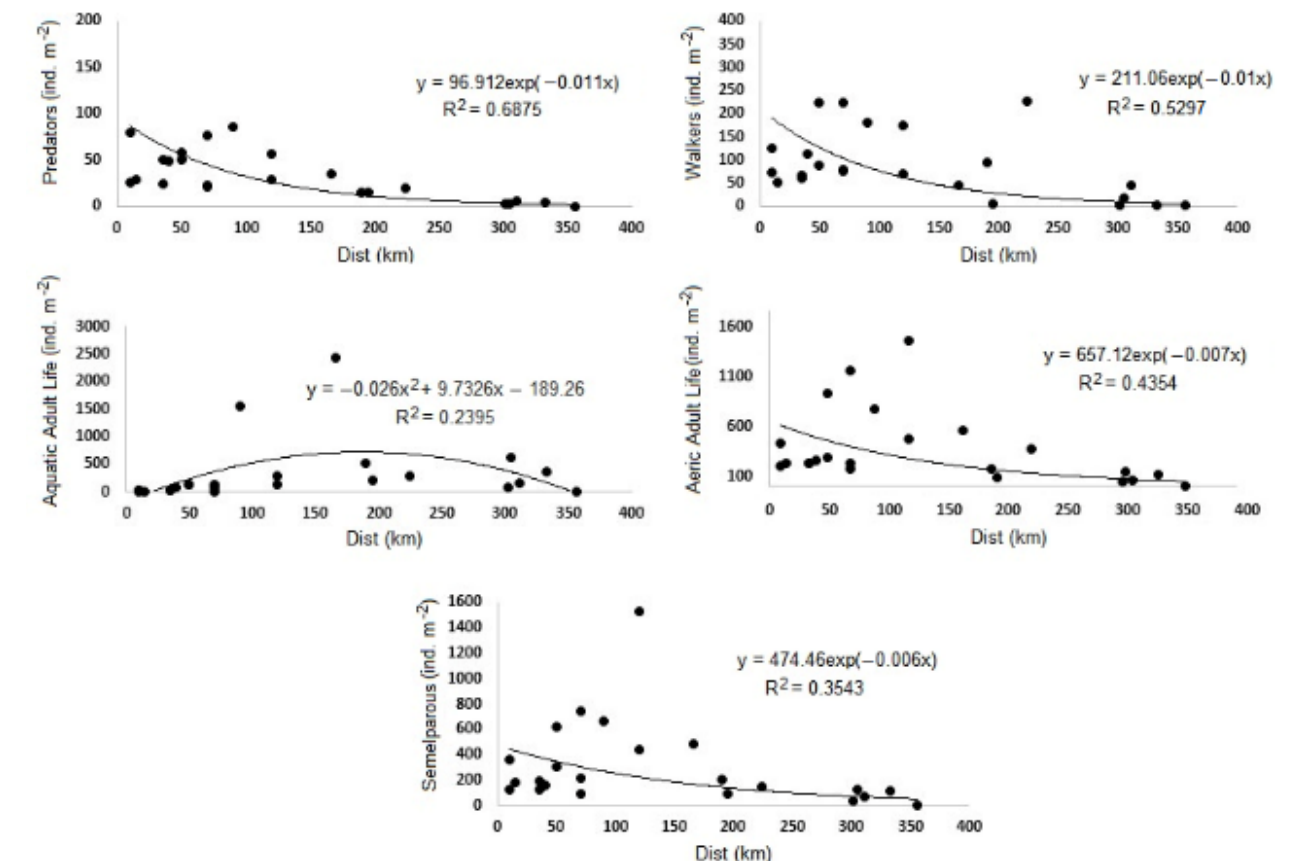
Figure 4. Regression models of distance from the source vs. biological traits.